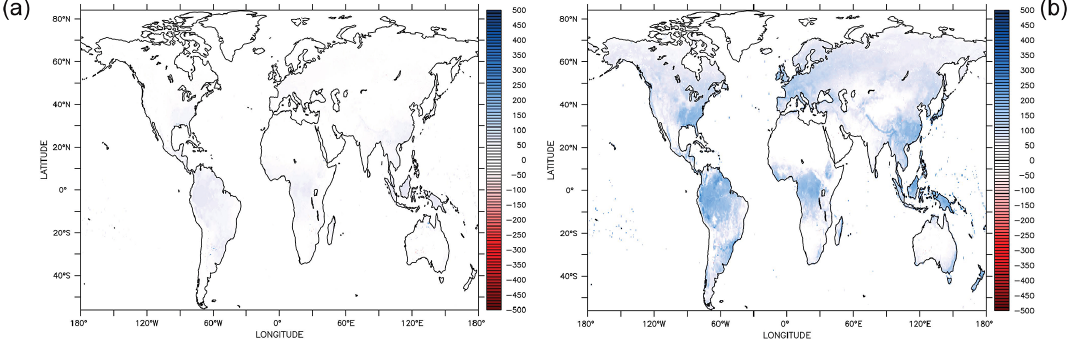
Figure 4. Parameter sensitivity on annual gross primary productivity (AGPP, average of 1901–2000) shown as the difference between new parameter and reference simulations. Both simulations have the Newton approach implemented. Increasing θ by 10% increased AGPP by 10% has a much larger effect on AGPP, especially in the tropics (b) . mainly in forested regions (a) . Increasing α C 3